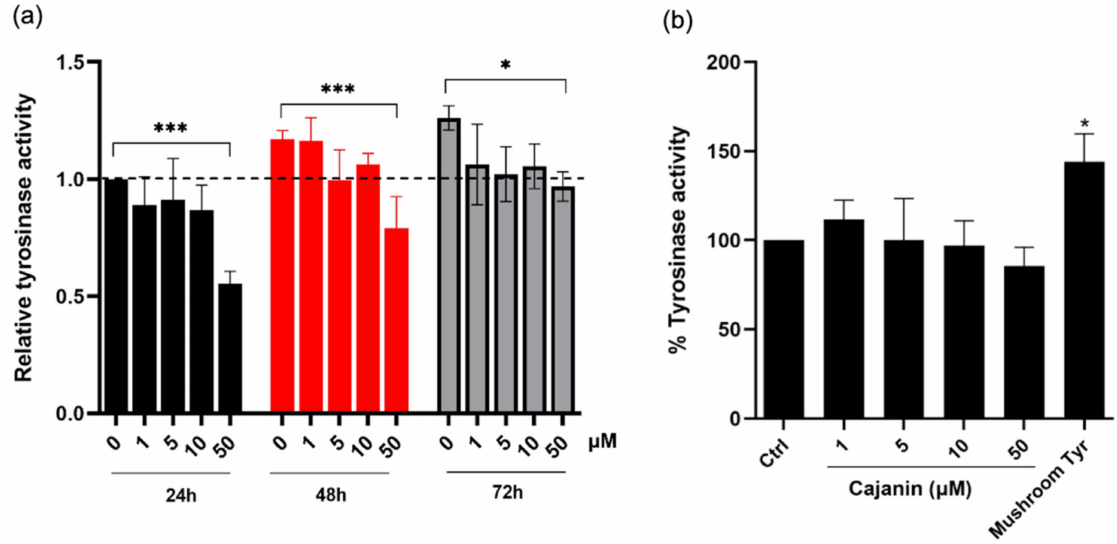
Figure 4. Inhibitory effect of cajanin on human tyrosinase activity assessed via cell-based and direct enzymatic assays. ( a ) Cellular protein lysates prepared from cajanin-treated human MNT1 cells showed lower tyrosinase activity. The signifi- cant attenuation of tyrosinase activity was observed in MNT1 cells cultured with 50 µ M cajanin for 24–72 h compared with the untreated control group. ( b ) Direct adding of cajanin at different concentrations (1–50 µ M) did not alter the melanogenic activity of tyrosinase enzyme isolated from human melanin-producing MNT1 cells. Mushroom tyrosinase (Tyr) at 100 unit/mL was used as a positive control for cell-free tyrosinase activity assay. Experiments were performed in triplicate and data are expressed as mean ± SEM. * p < 0.05, *** p < 0.005 versus non-treated cells